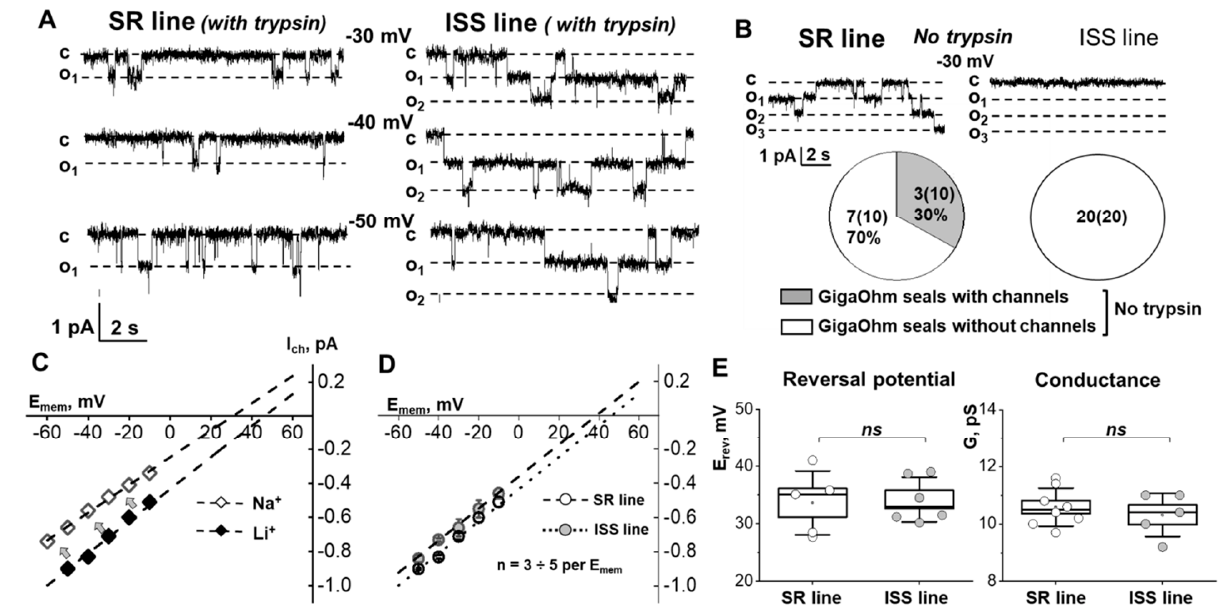
Figure 5. ENaC-like channels recorded in SR and ISS cell lines . ( A ) Representative current traces showing single ENaC-like channels’ activity in SR and ISS cell lines recoded at different membrane potentials using patch-clamp electrophysiology. ( B ) Channel prevalence in successful GigaOhm seals in SR and ISS cell lines without stimulation with trypsin. Representative current traces are shown at − 30 mV. ( C ) IV curve demonstrating lower single conductance of ENaC-like channels in a SR cell line with Na + as main cation in the pipette vs. Li + . ( D ) Cumulative IV curves for single ENaC-like channels recorded in SR and ISS cell lines. ( E ) Summary graphs demonstrating reversal potential and single channel conductance (SR line: E rev = 34.1 ± 1.5 mV, n = 4, and 10.5 ± 0.7 pS n = 8 vs. ISS line: E rev = 33.6 ± 5.5 mV, n = 6, and 10.3 ± 0.8 pS, n = 5, t